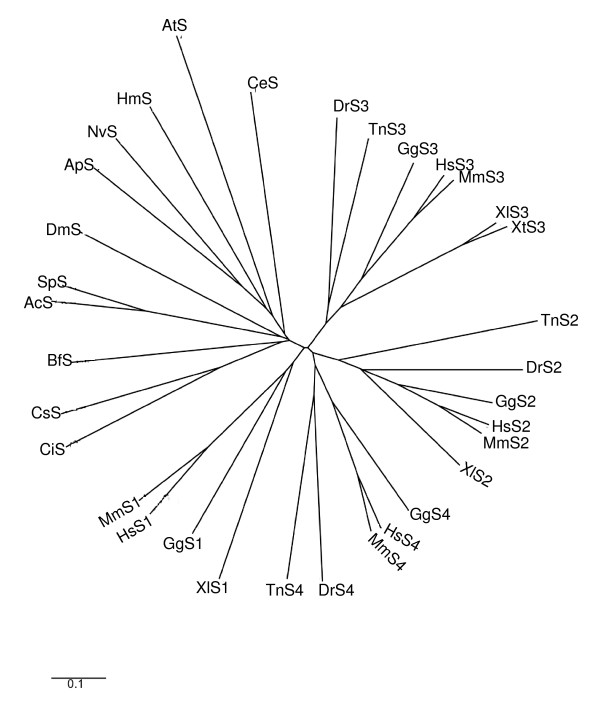
Sequence relationships of invertebrate and vertebrate syndecans. The amino acid sequences of all the full-length syndecans in the dataset were aligned in TCOFFEE. The Phylip distance matrix output was used to prepared an unrooted phylogenetic diagram in DRAWTREE. Key is the same as in Figure 1. Scale bar = 0.1 substitution/site.